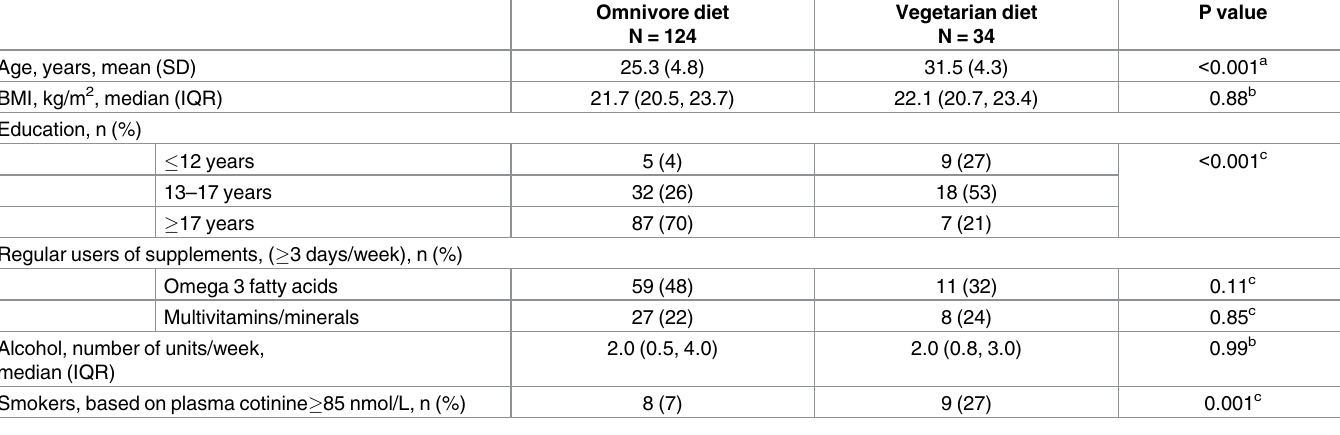
Table 1. Baseline characteristics of healthy, never-pregnant women according to diet (n =